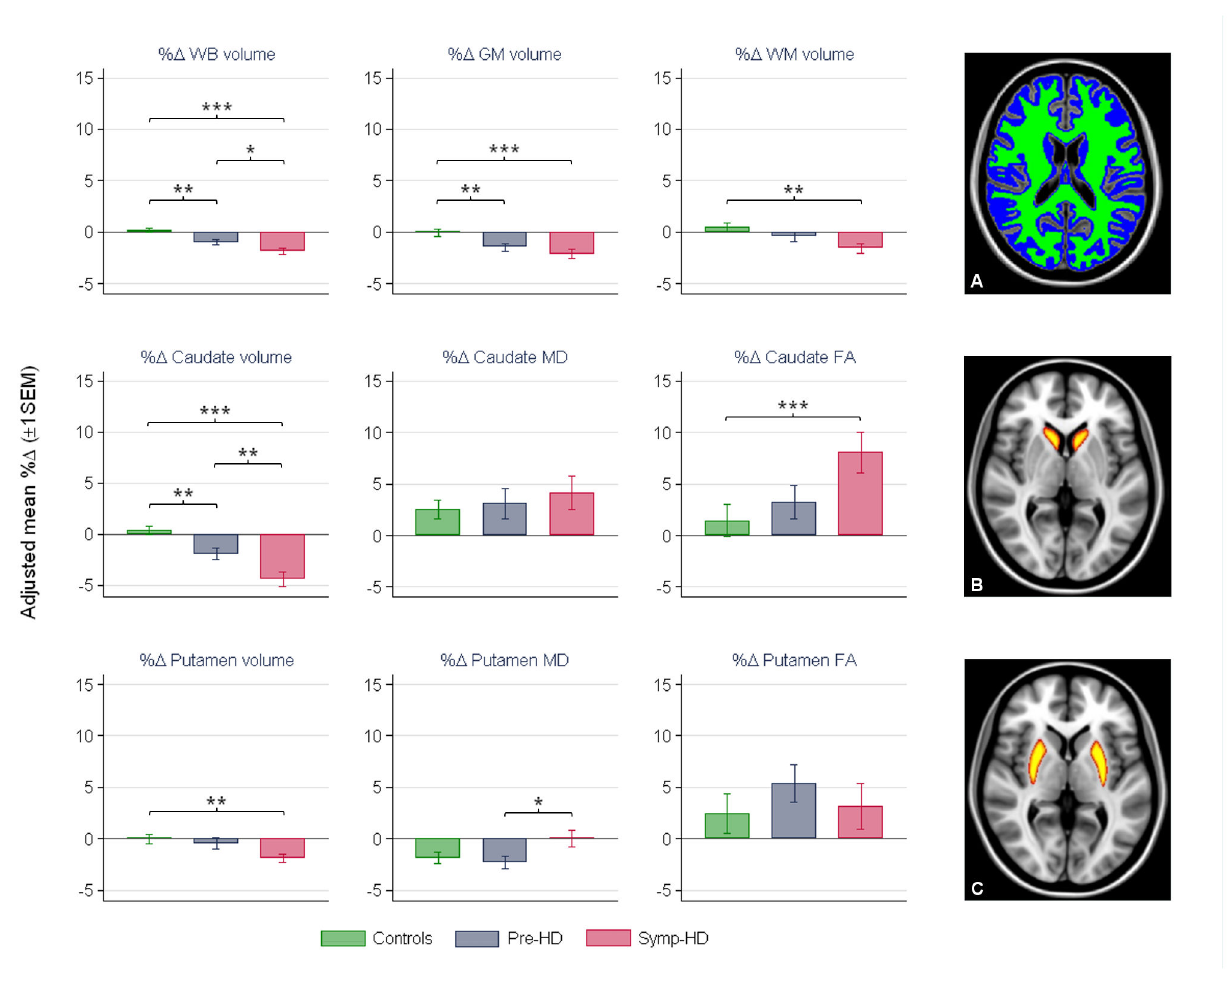
Figure 1. Mean percent change of baseline (%Δ) and significant group differences in volume and diffusion measures adjusted for age. Top row: brain-wide percent volume change: whole brain (WB), gray matter (GM) and white matter (WM); middle and bottom rows: subcortical percent volume, MD and FA change (caudate and putamen, respectively). Stars indicate significant between-group differences: * p ≤ .05; ** p ≤ .01; *** p ≤ .001. Cortical and subcortical segmentations overlaid on MNI T standard brain are provided in right column: A) grey and white matter depicted in blue and green, respectively; B) caudate and C) putamen are represented in